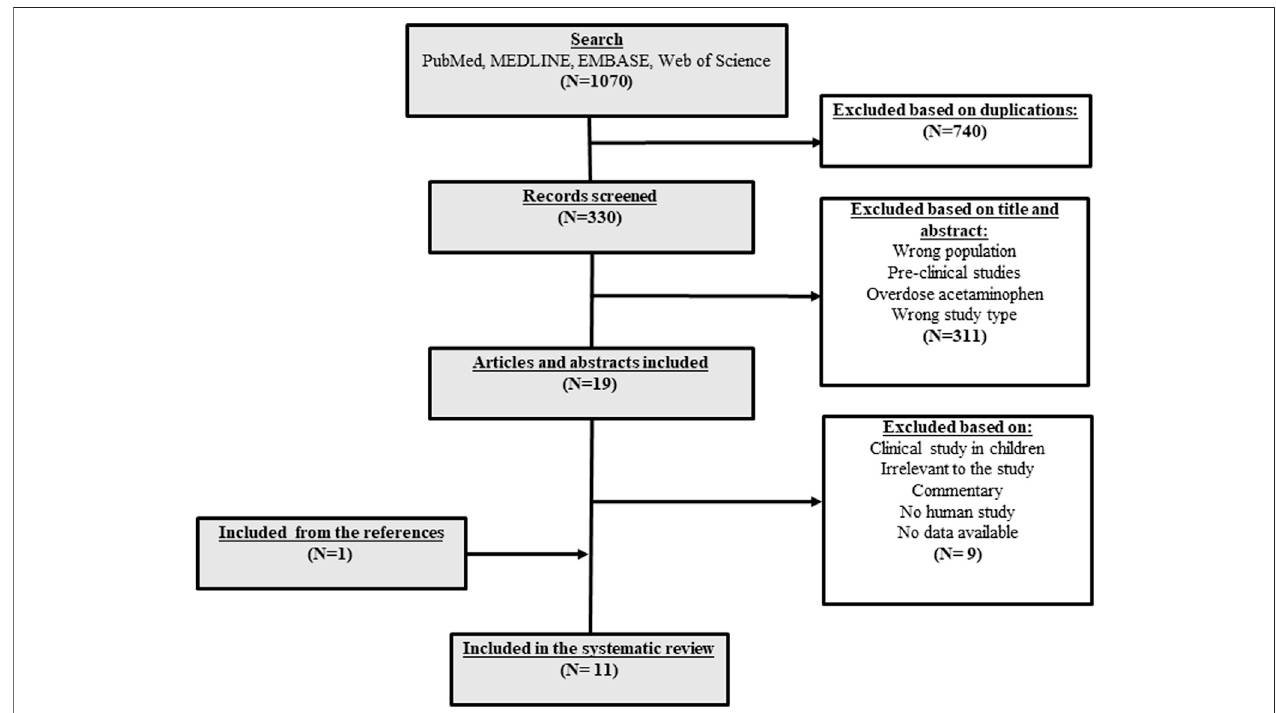
FIGURE 1 | Flowchart of the search of publications about the role of NAC in DILI treatment and prevention.